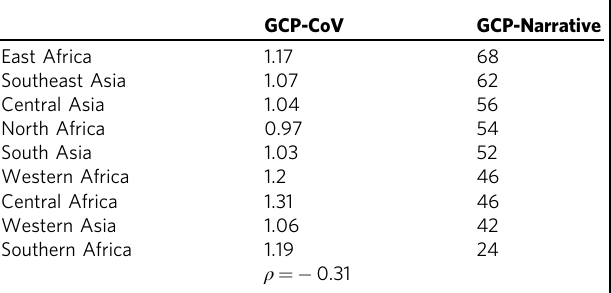
Table 4 Subregion level comparison of GPC-CoV and GCP- Narrative